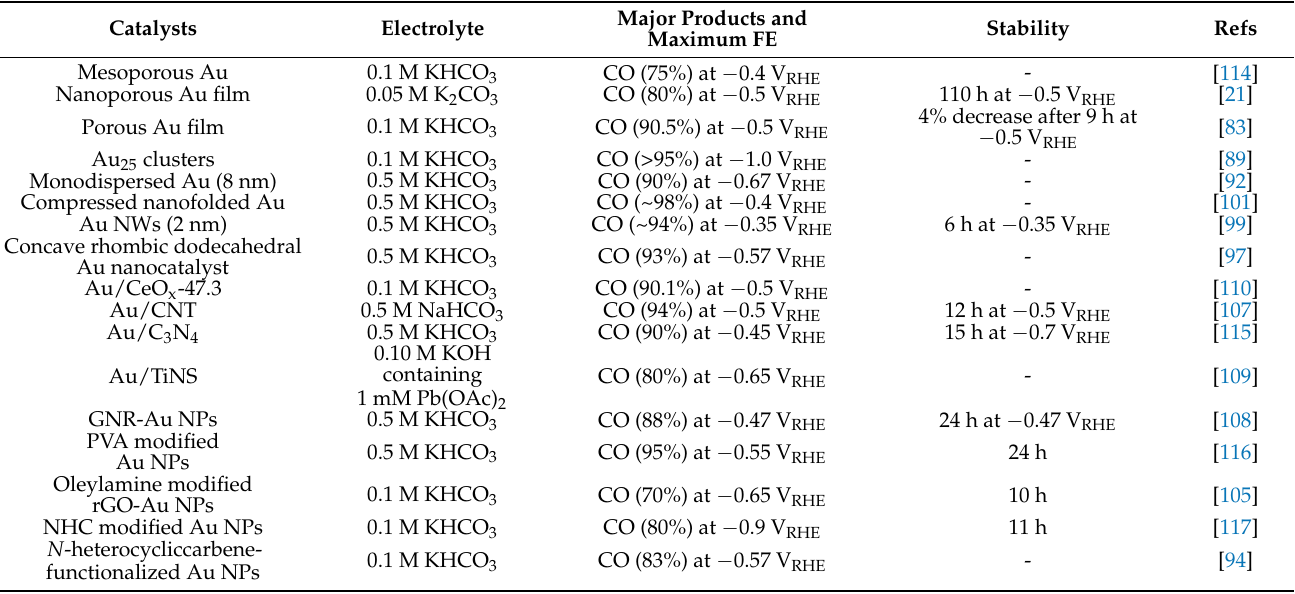
Table 2. Summary of the catalytic performance of representative sole Au-based nanocatalysts for the CO 2